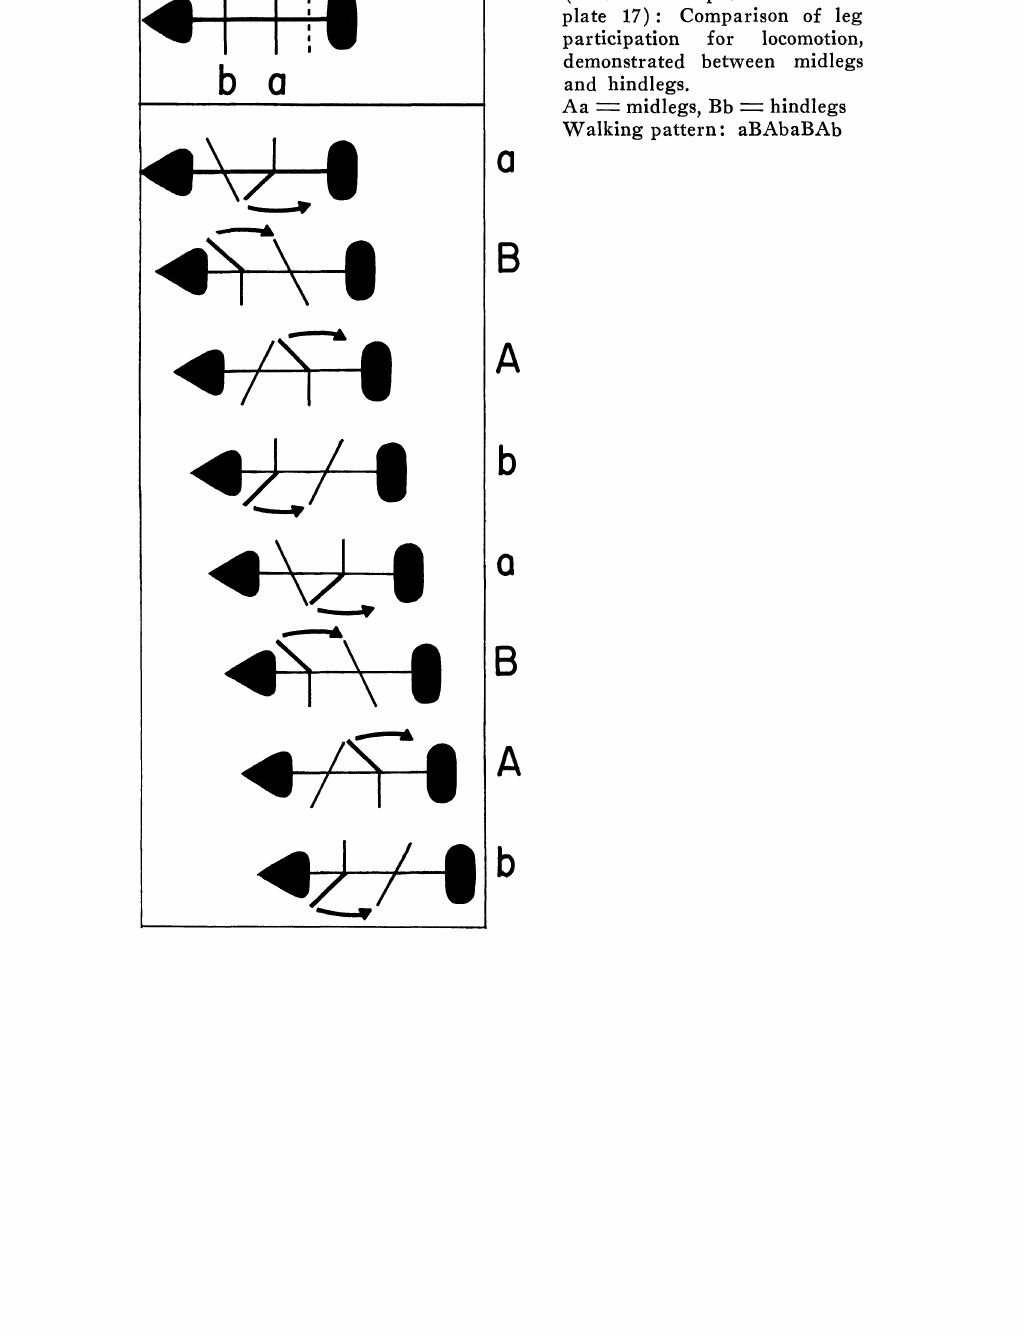
Fig. 2 Regular walking (schematic representation of plate 17) Comparison of leg participation for locomotion, demonstrated between midlegs and hindlegs. Aa midlegs, Bb hindlegs Walking pattern: